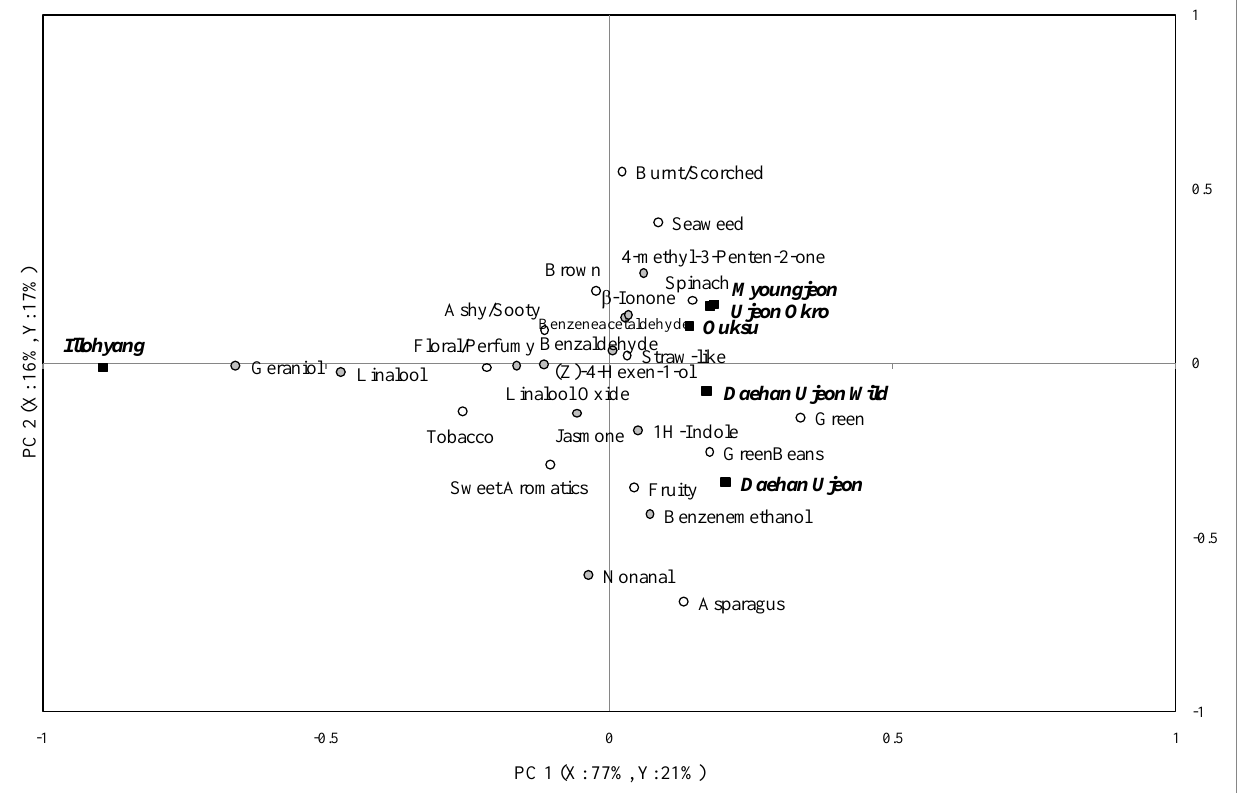
Figure 2. Partial least square regression analysis of descriptive sensory and gas chromatography data for the first brew of green tea